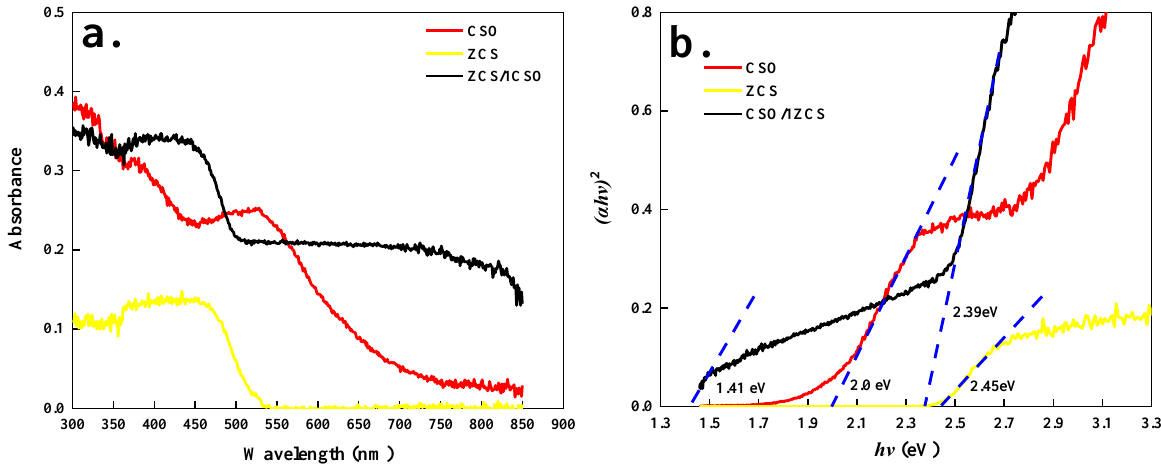
Figure 2. UV–vis diffuse reflectance spectra for ZCS, CSO, and ZCS/1CSO compounds ( a ), and the plotting results of band gaps energy for ZCS, CSO, and ZCS/1CSO compounds ( b ), the blue line presents the straight line part (in the hv and ( αhν ) 2 relation curve.